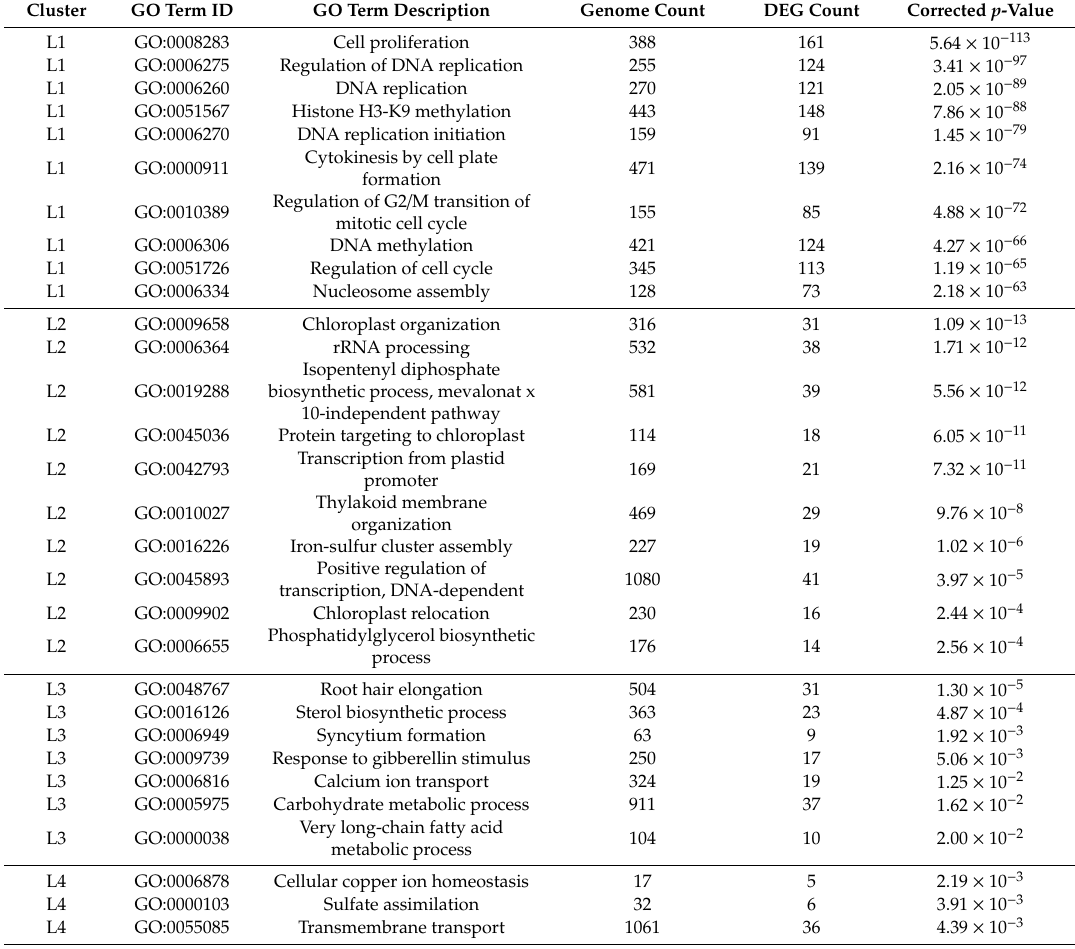
Table 1. Top ten Gene Ontology (GO) Biological Process terms significantly overrepresented in leaf expression clusters